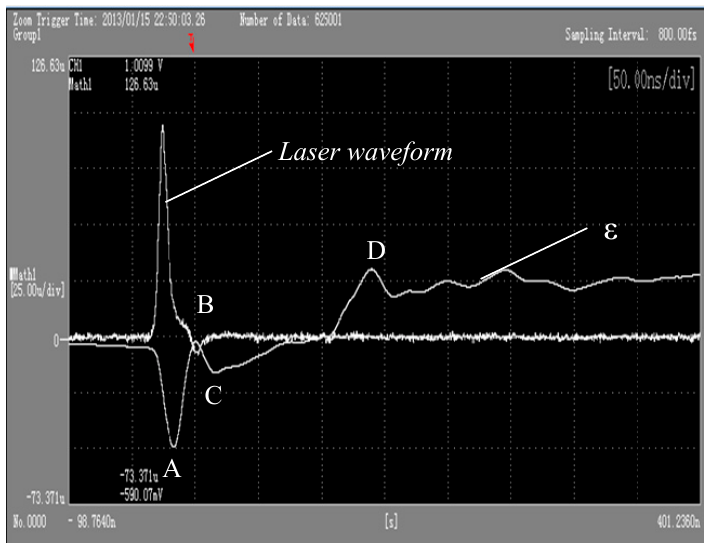
Figure 11. A strain curve of the target surface when the wavelength is 1064 nm and laser power density is 6.3 GW/cm 2 .